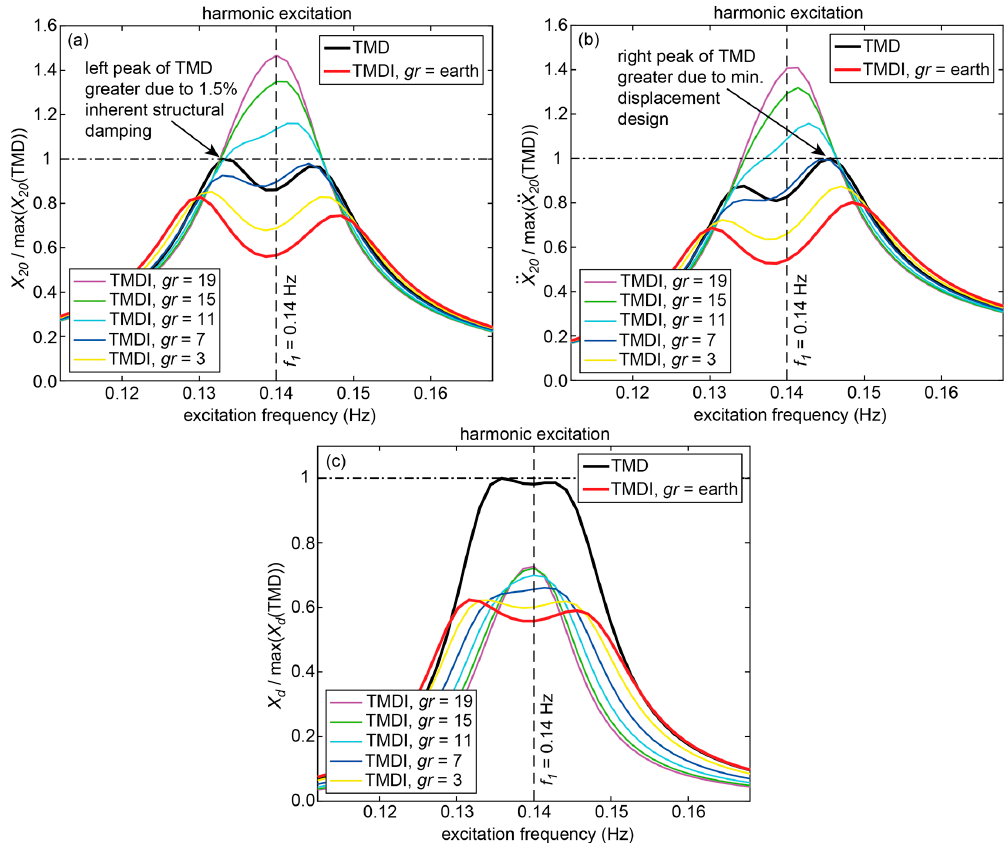
Figure 5. Transfer function between the maximum structural displacement (level 20) and the excitation force: ( a ) results for the frequency range of mode 2; ( b ) results for the frequency range of mode 3.